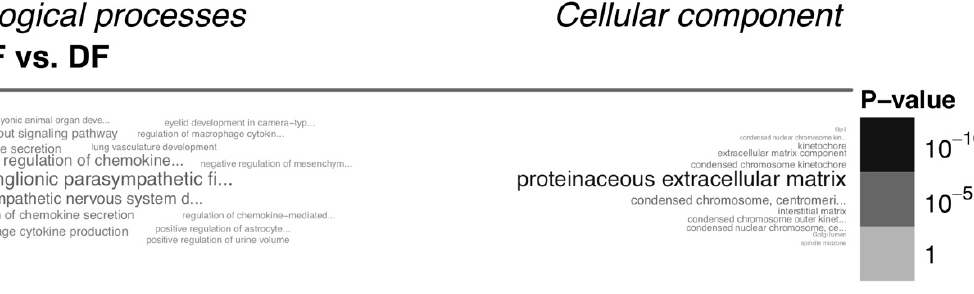
Figure 4. Functional enrichment of the genes differentially expressed between mucous and dermal fibroblasts. This figure shows the gene set enrichment analysis using the Gene Ontology terms, showing the difference between normal mucosa fibroblasts from the oral cavity (MuF) and facial skin (DF). The figure is based on the authors’ data.